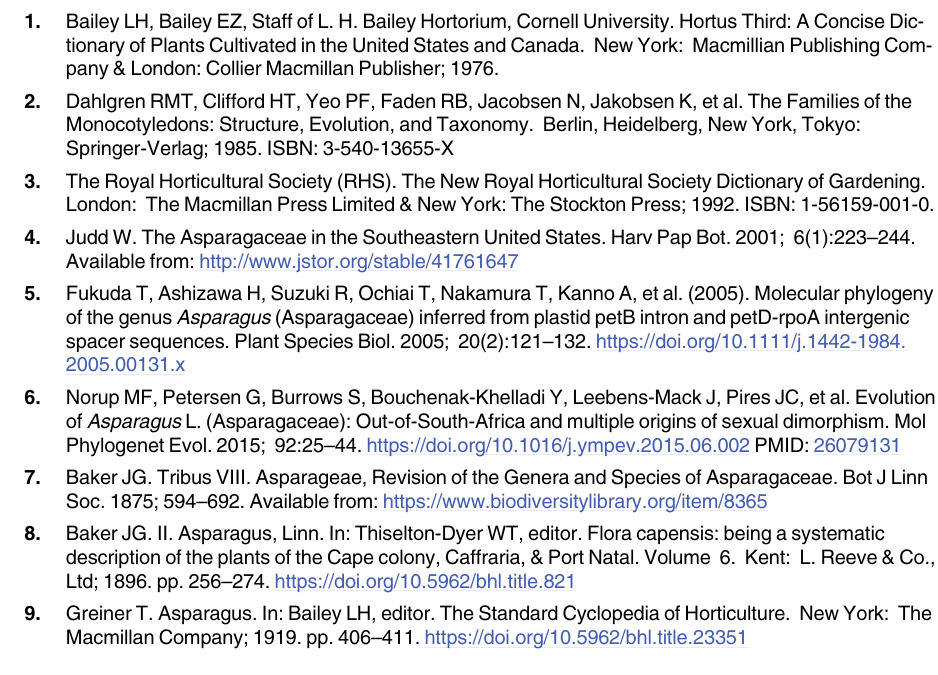
S1 Table. The historical changes on taxonomical status of the 7 studied Asparagus